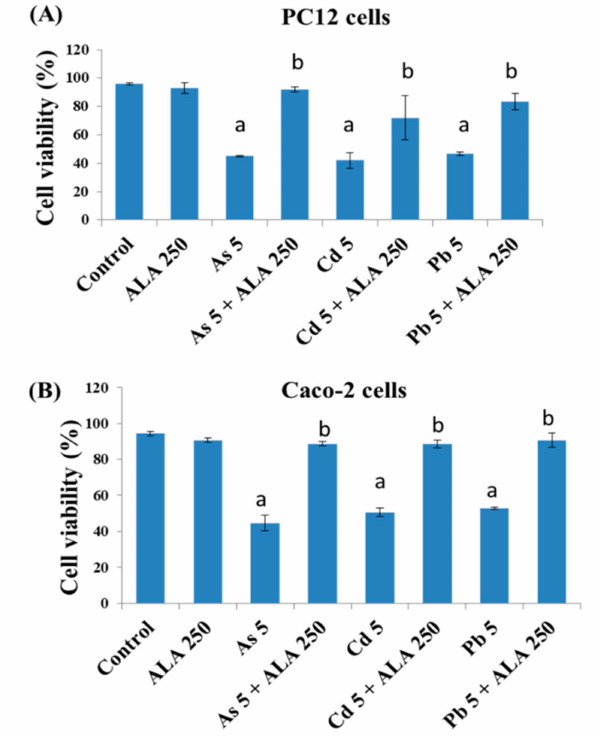
Figure 3. Cell viability of ( A ) PC12 cells and ( B ) Caco-2 cells after exposure to toxic metals and/or ALA for 48 h of incubation. The values of the bars indicate the mean ± SEM ( n = 5). Here, “a” denotes a significant difference compared to the control group ( p < 0.05), and “b” denotes a significant difference compared to the associated metal group ( p < 0.05).